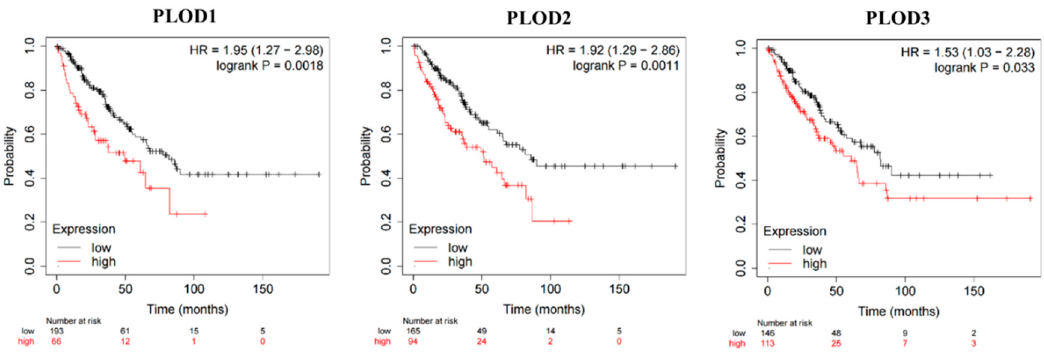
Figure 2. The survival analysis of expression of PLOD1–3 in STS. High expression of PLOD1, PLOD2, and PLOD3 were related with poor OS in